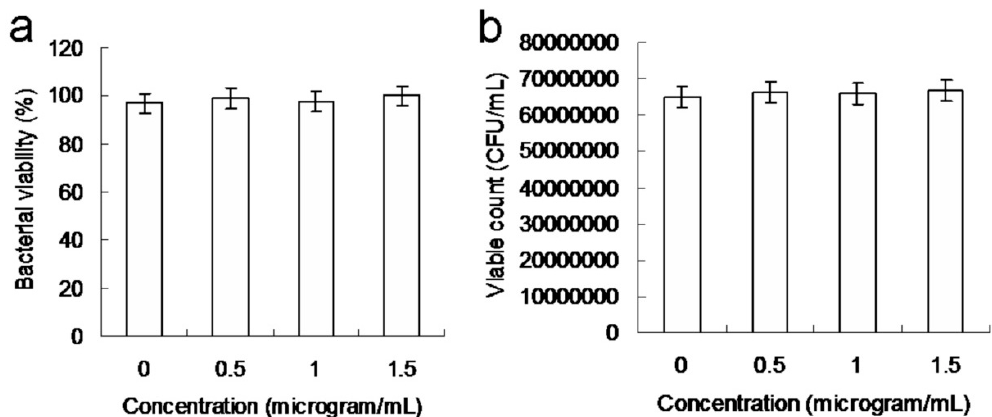
Figure 2. Number of surviving ( a ) amino-N-GQD–Ab protein A -treated methicillin-resistant Staphylococcus aureus (MRSA) cells (expressed as a percentage) based on the colony-forming unit (CFU) counting assay, and ( b ) MRSA cells (unit: CFU/mL). Delivered dose: OD 600 = ~0.05 µ g · mL − 1 for bacteria and 0–1.5 µ g · mL − 1 for material–Ab protein A . Data are presented as mean ± SD ( n = 6).